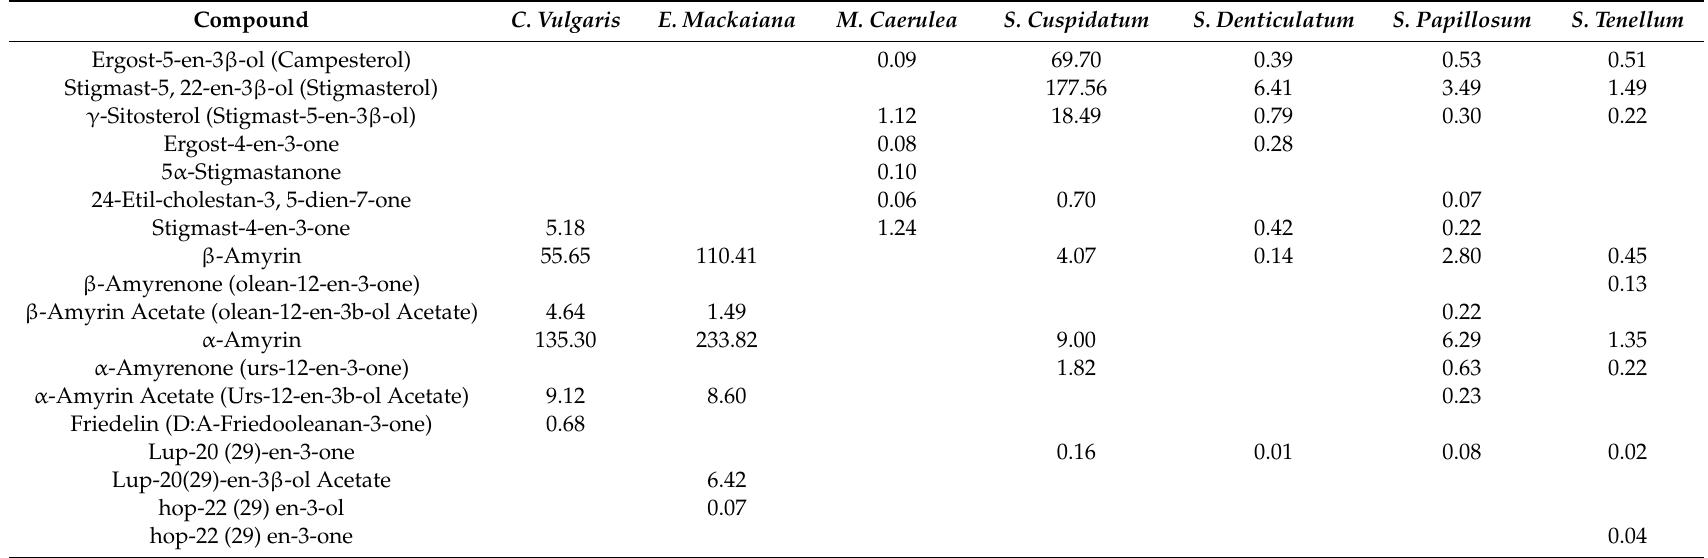
Table 1. Concentrations of triterpenoid and steroid derivatives ( µ g / g) in the Roñanzas peat-forming